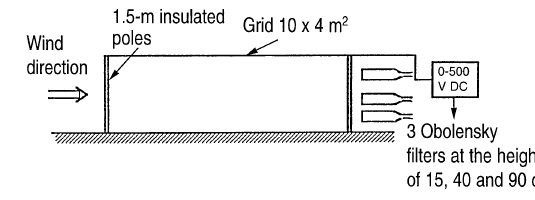
Fig. 1. Experimental set-up